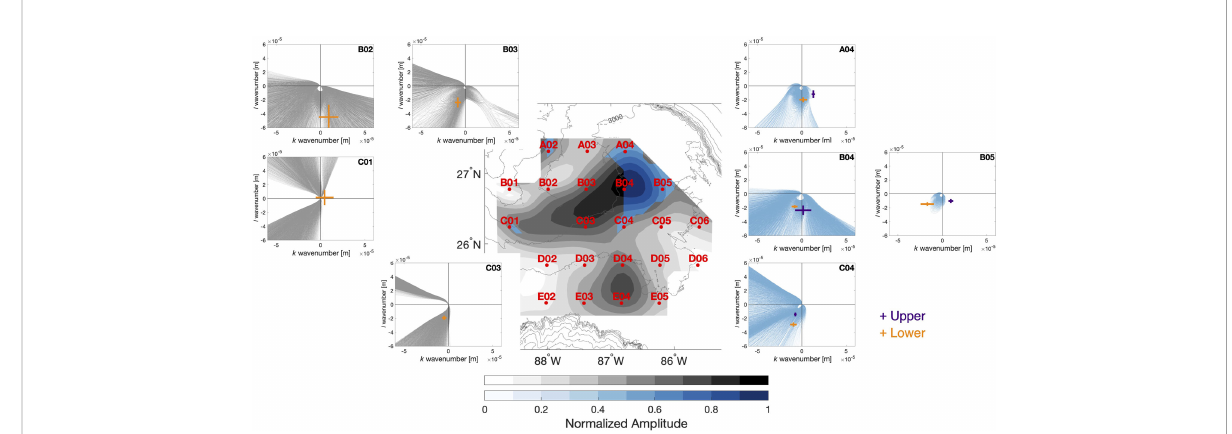
FIGURE 10 Central panel: normalized spatial amplitude from the coupled CEOF of the 1/20 – 1/10 day – 1 band-passed reference sea surface, SSH ref , during LCE Ursa detachment (same as Figure 9C). CPIES locations are marked in red and labeled. Bathymetry is contoured in gray every 250 meters. Outside panels: the TRW dispersion curves calculated for each bathymetric slope within a 60-km square kilometer box around the corresponding CPIES sites. To calculate the dispersion relationship, frequency ( w = 1/15 day – 1 ) and strati fi cation ( N = 15×10 – 4 s – 1 ) are kept constant across the array and bathymetry is smoothed using a 60-km Gaussian fi lter. The dispersion relations plotted in blue correspond to sites that fall within the blue region on the spatial amplitude (central) plot and represent regions where we hypothesize TRWs have been generated. The dispersion relations plotted in gray correspond to sites within the region of high spatial amplitude where we hypothesize TRWs are freely propagating. Orange and purple crosses represent the standard deviation of the SSH ref (lower) and SSH bcb (upper), respectively, wavevectors local to the corresponding CPIES